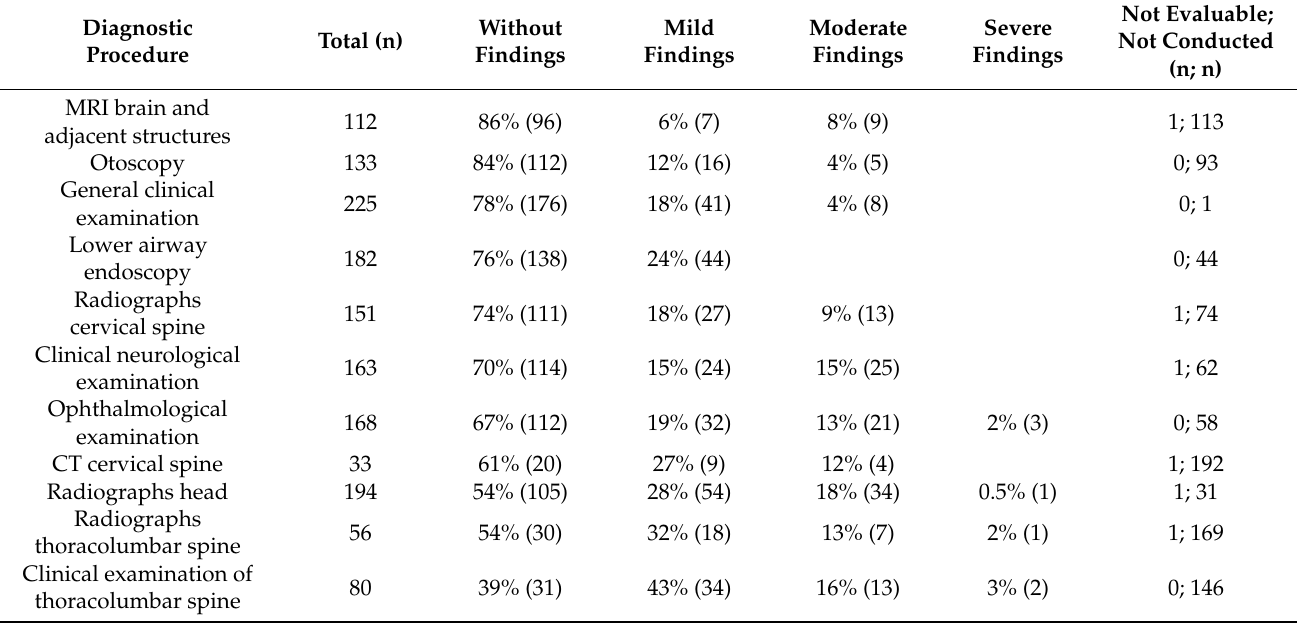
Table 1. Results of different diagnostic procedures. Relative (%) and absolute abundance (n) of findings are shown for every procedure categorised by severity. Diagnostic procedures are listed from the top to the bottom from the highest number of mild findings to the lowest. Relative abundance (%) (n); CT: computed tomography, MRI: magnetic resonance